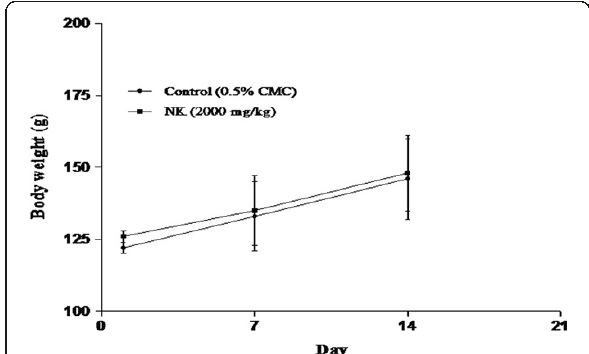
Figure 2 Effect of Nuna kadugu on body weight in control and NK rats - Acute oral toxicity study. Note: Values expressed as mean ± SEM